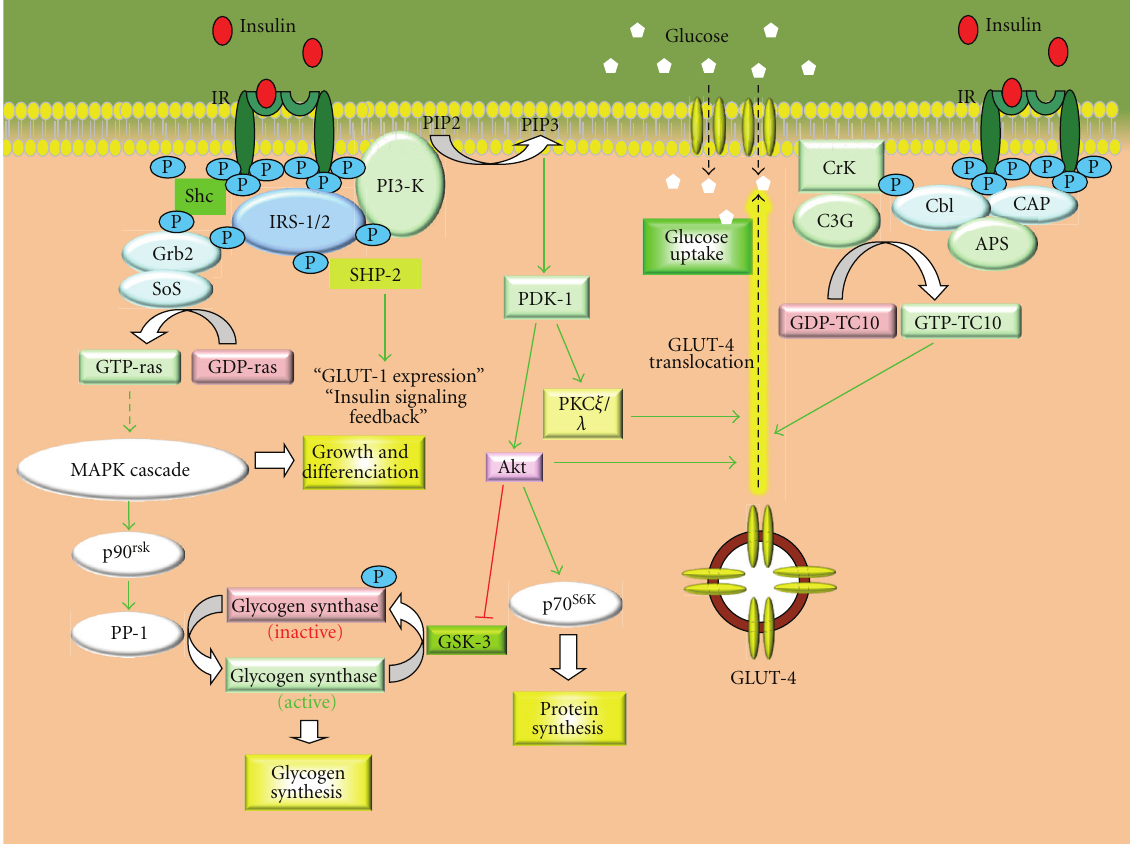
Figure 1: Summary of the main insulin signaling pathways. GLUT-1 and -4: glucose transporter-1 and -4; Grb-2: growth receptor binding-2; GSK-3: glycogen synthase kinase-3; IR: insulin receptor; IRS-1 and -2: insulin receptor substrate-1 and -2; MAPK: mitogen-activated protein kinase; PDK-1: phosphoinositide-dependent kinase-1; PIP2: phosphatidyl-inositol diphosphate; PI3: phosphatidyl-inositol triphosphate; P: phosphate; PKC: protein kinase C; PP-1: phosphoprotein phosphatase-1; p70S6 K: protein 70 S6 kinase; p90rsk: protein 90 ribosomal S6 kinase; Shc: Src homology collagen; SHP-2: phosphatase with Src homology 2 domain; SoS: Son of